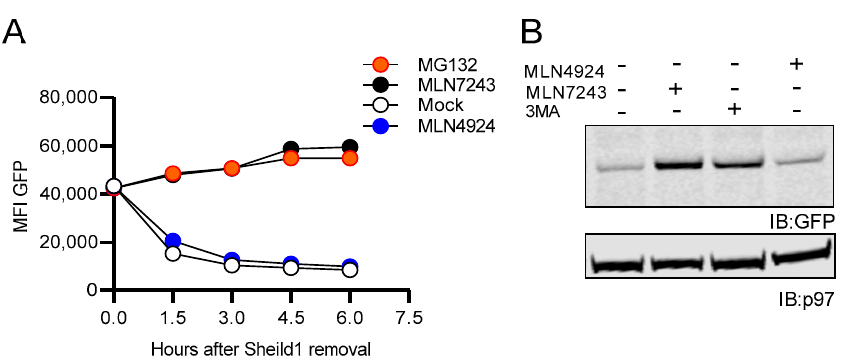
Figure 8. Ubiquitination, but not NEDDylation, is required for the rapid degradation of SCRAP-